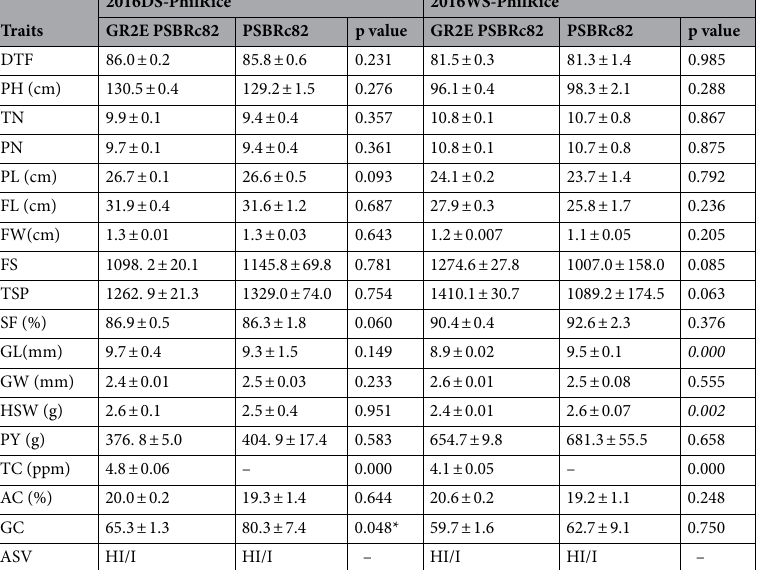
Table 2. Agronomic and grain quality performance of GR2EPSBRc82 at PhilRice. DTF days to fifty percent flowering, PH plant height, TN Tiller number, PN Panicle number, PL Panicle length, FL flag leaf length, FW flag leaf width, FS number of filled spikelets, TSP total number of spikelets per plant, SF spikelet fertility, GL grain length, GW grain width, HSW hundred seed weight, PY plot yield, TC total carotenoids, AC amylose content, GC gel consistency, ASV alkali spreading